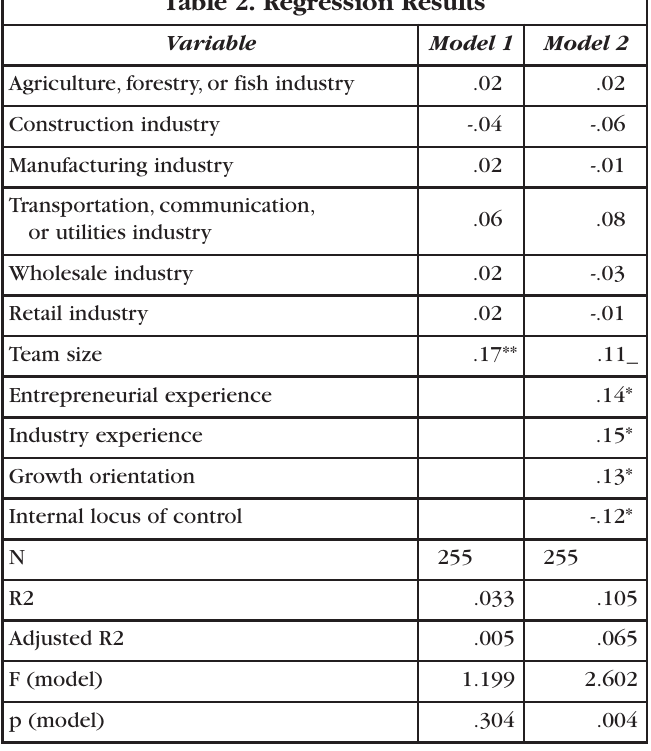
Table 2. Regression